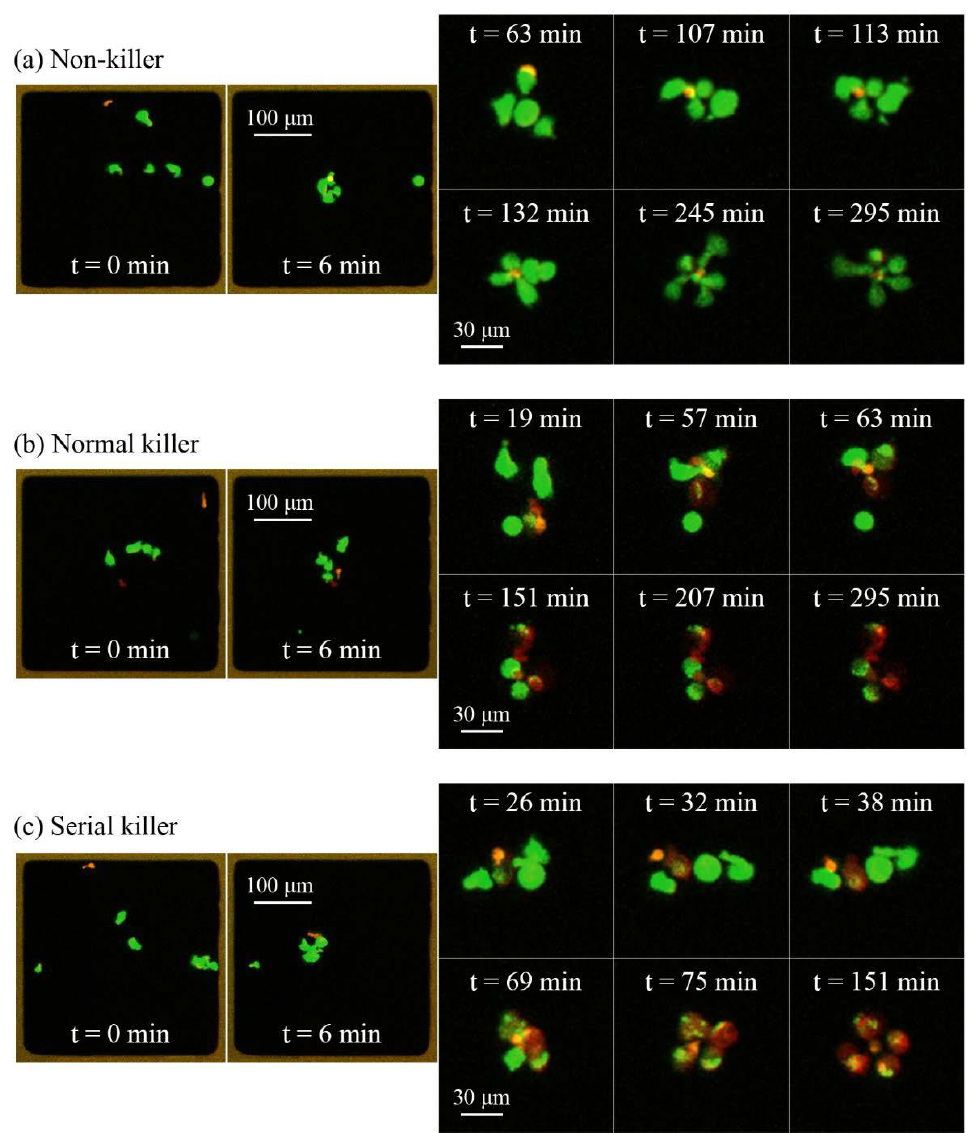
Figure 11. Time-lapse recordings of three parallel events among the 100 wells of the ultrasonic microplate in a 5 h cytotoxic assay. NK cells are shown in orange (orange calcein-AM), living target cells are shown in green (green calcein-AM) and dead target cells in red (far-red DDAO-SE). ( a ) Continuous interaction of a non-active NK cell (non-killer) with four to five targets (target cell division at t = 132 min) during the entire assay does not result to any NK cell mediated death; ( b ) Normal killer induces killing at t = 19 and 57 min, but remains inactive (although in contact with living target) for the remaining experiment; ( c ) Serial killer eliminating all four target cells within 75